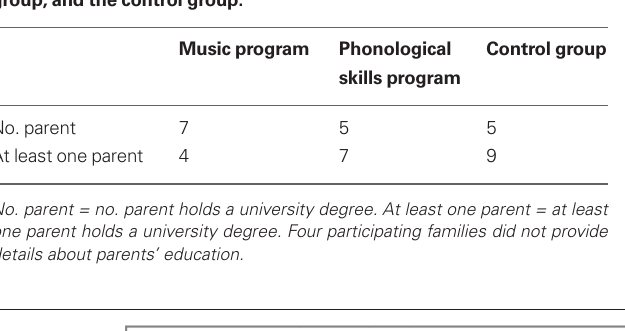
Table 2 | Distribution of parents’ education as a measure of socioeconomic status within the music group, the phonological skills group, and the control group.